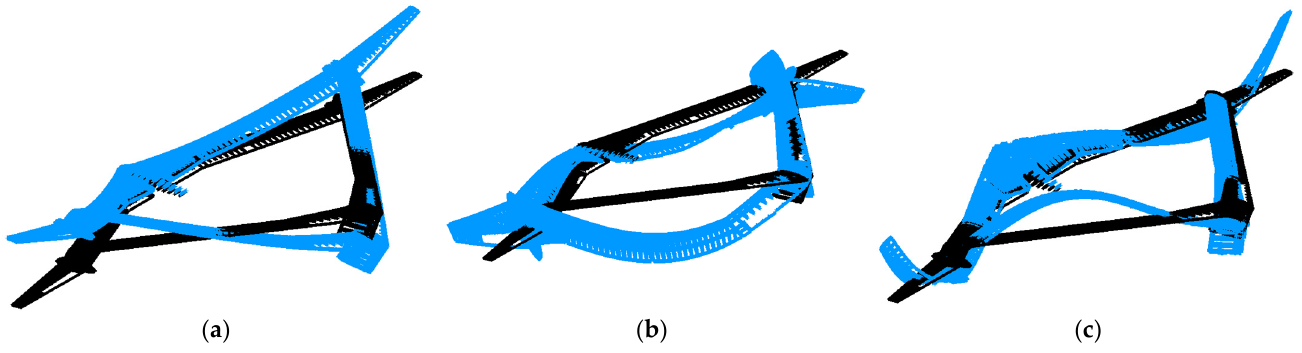
Figure 9. Several primary elastic mode shapes: ( a ) 7th mode—symmetric vertical bending, f 1 = 0.354 Hz; ( b ) 13th mode—anti-symmetric vertical bending coupled with torsion, f 7 = 1.101 Hz; ( c ) 30th mode—symmetric vertical bending coupled with torsion, f 30 = 3.234